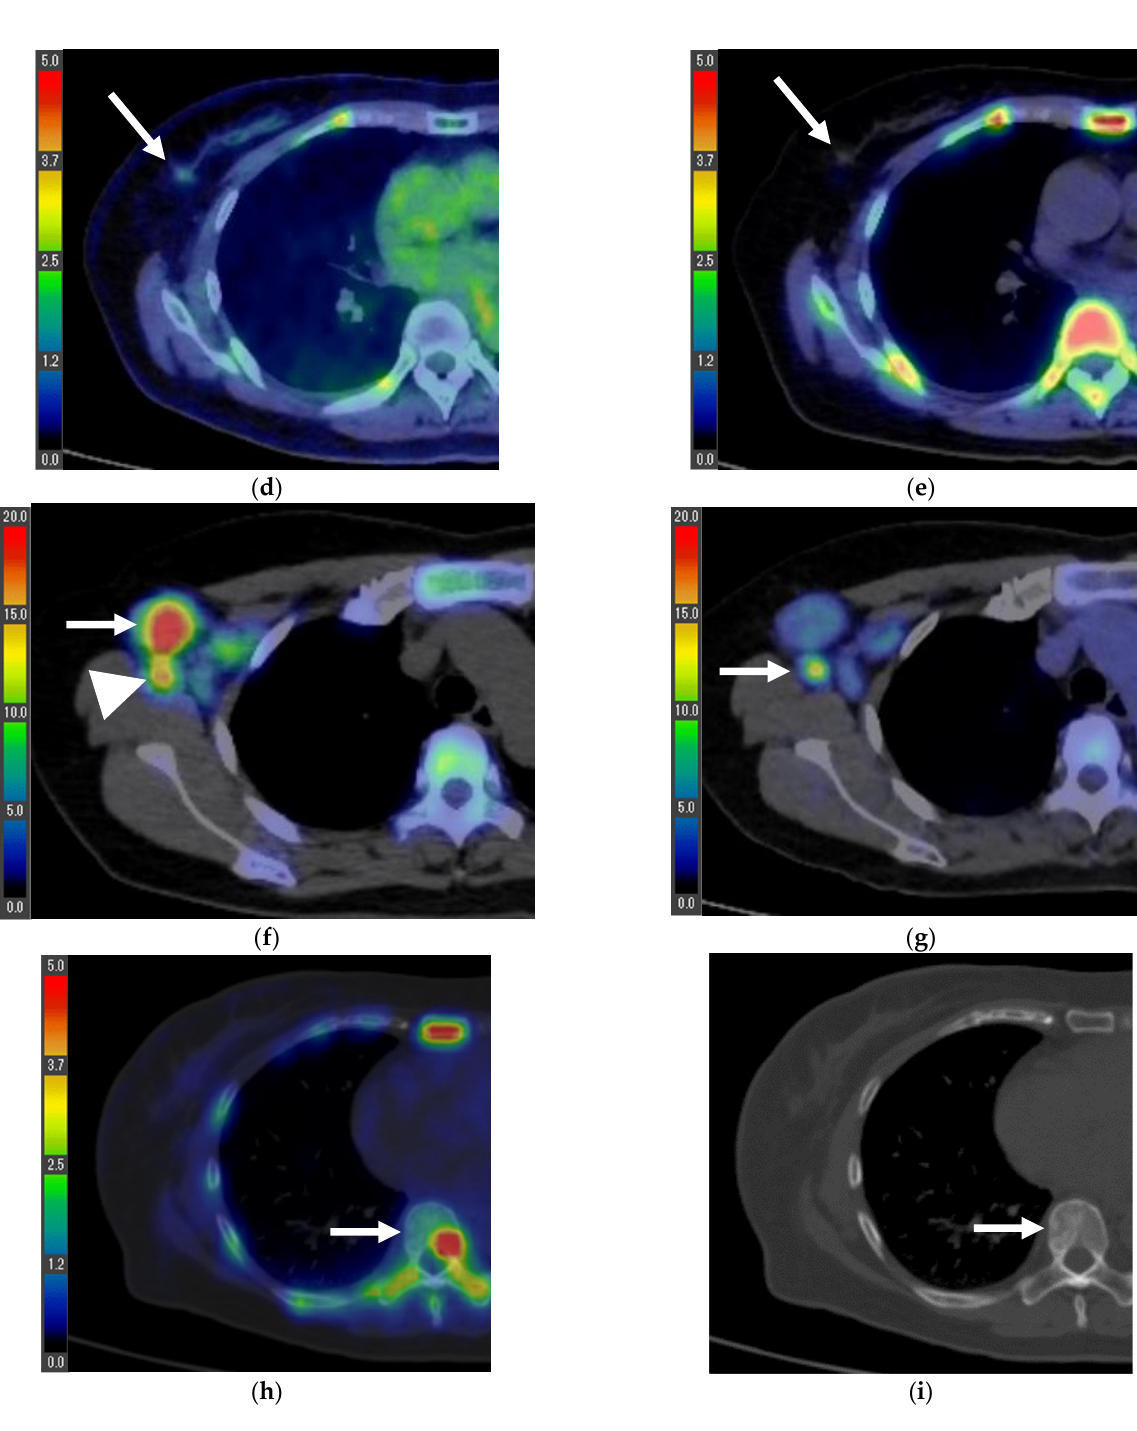
Figure 2. First maximum intensity projection (MIP) of 18 F-FDG PET ( a ), MIP of 18 F-FLT PET per- formed 3 days later ( b ), and MIP of 18 F-FLT PET performed 5 months later ( c ). In the axial image of the PET/CT at the slice of the primary right breast cancer, both the 18 F-FDG PET/CT and 18 F-FLT PET/CT showed trace accumulation (( d , e ), arrows). The axillary lymph node with the greatest accumulation differed between the 18 F-FLT PET/CT ( f ) and 18 F-FDG PET/CT ( g ), and the SUVmax values were 30.0 and 14.2, respectively (arrows). The lymph node corresponding to the node with the greatest accumulation on the 18 F-FDG PET/CT showed an SUVmax of 16.7 on the 18 F-FLT PET/CT (( f ), arrowhead). The post-chemotherapy thoracic spine metastasis showed low 18 F-FLT accumula- tion and bone sclerosis, suggesting that cell proliferation had decreased (( h , i ), arrows). Patient 4 (Figure 2).